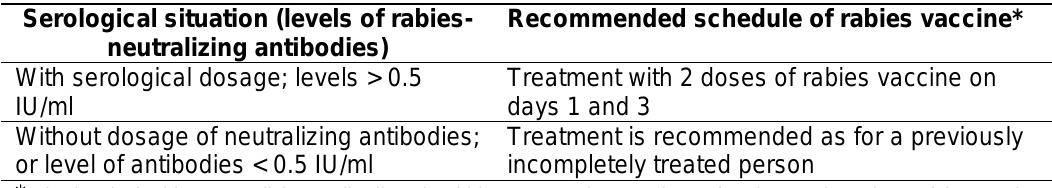
Table 7: Post-exposure rabies treatment of pre-exposure vaccinated patients. Serological situation (levels of rabies- Recommended schedule of rabies vaccine* neutralizing antibodies) With serological dosage; levels > 0.5 Treatment with 2 doses of rabies vaccine on IU/ml days 1 and